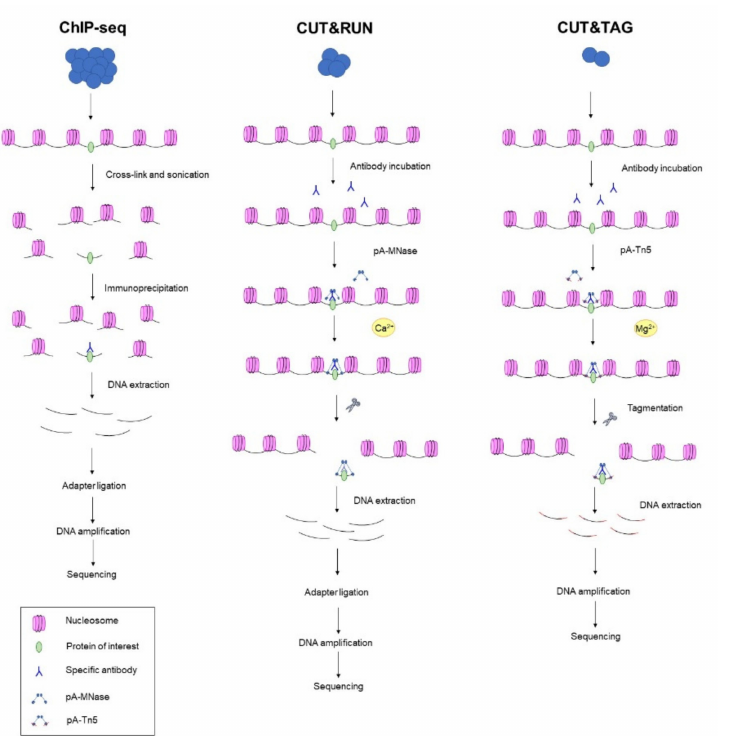
Figure 4. Graphic illustration of the principal technological approaches for epigenetic chromatin profiling. ChIP-seq is a well-used method to profile DNA–protein interactions. In this method, after crosslink and DNA fragmentation, a hybridisation step with a specific antibody against a protein of interest is needed. After DNA extraction, library preparation can be performed. CUT&RUN is an enzyme-tethering strategy that, after in situ incubation with a specific antibody, makes use of a micrococcal nuclease fusion protein (pA-MNase) for DNA fragment generation. CUT&TAG is the most recent methodology introduced for epigenome features profiling. As with CUT&RUN, it begins with an antibody incubation but exploits the transposome Tn5-transposase-protein A (pA-Tn5) fusion protein loaded with sequencing adapters for tagmentation and